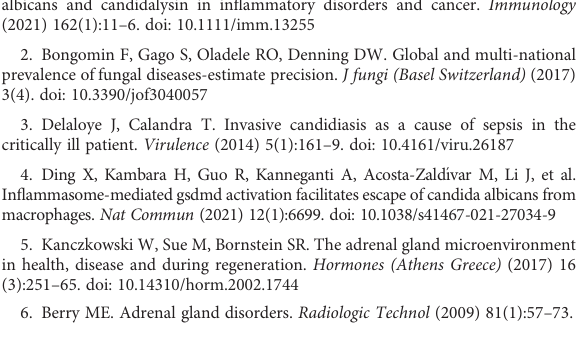
TABLE S1 Previously reported cell type-speci fi c markers for annotation of the cells in murine adrenal glands. TABLE S2 Cell statistics of scRNA-seq before and after QC. TABLE S3 The marker genes for each cell cluster identi fi ed with the FindAllMarkers function. TABLE S4 The DEGs of different modules along the pseudo-time trajectory in adrenlcortical cells. TABLE S5 The DEGs in the endothelial cells. TABLE S6 The DEGs in macrophages. FIGURE S1 Expression levels of speci fi c markers for each cell type are plotted onto theUMAP. (A) Adrenocortical cells; (B) Endothelialcells; (C) Macrophages; (D) Mesenchymal cells; (E) NK cells; (F) B cells; (G) Dendritic cells; (H) Monocytes; (I) Neutrophils (Figure S1I). (J) CD4+ and CD8+ T cells; (K) Erythriod markers; (L) Smooth muscle cells; (M) Adrenal capsule; (N) Neurons and glial cells; (O) Chromaf fi n cells. FIGURE S2 (A) Group display of pseudo-time trajectory of adrenocortical cell subclusters (AACs). Each AAC is displayed separately on the trajectory. (B – E) GO and KEGG analyses of modules 1-4 of DEGs along the pseudo- time trajectory. FIGURE S3 The violin plots showing the expressions of the key genes encoding the pattern recognition receptors (PRRs) and the related key signaling molecules that are involved in innate antifungal recognition in macrophages from the infected mice (Ca) and uninfected controls